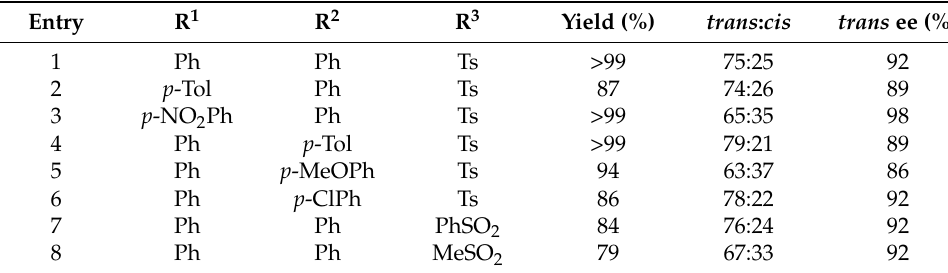
Scheme 33. Saito’s catalytic enantioselective synthesis of aziridines. Table 10. Scope of sulfide 12 -catalyzed aziridination (Scheme Table 10. Scope of sulfide 12 -catalyzed aziridination (Scheme 33).